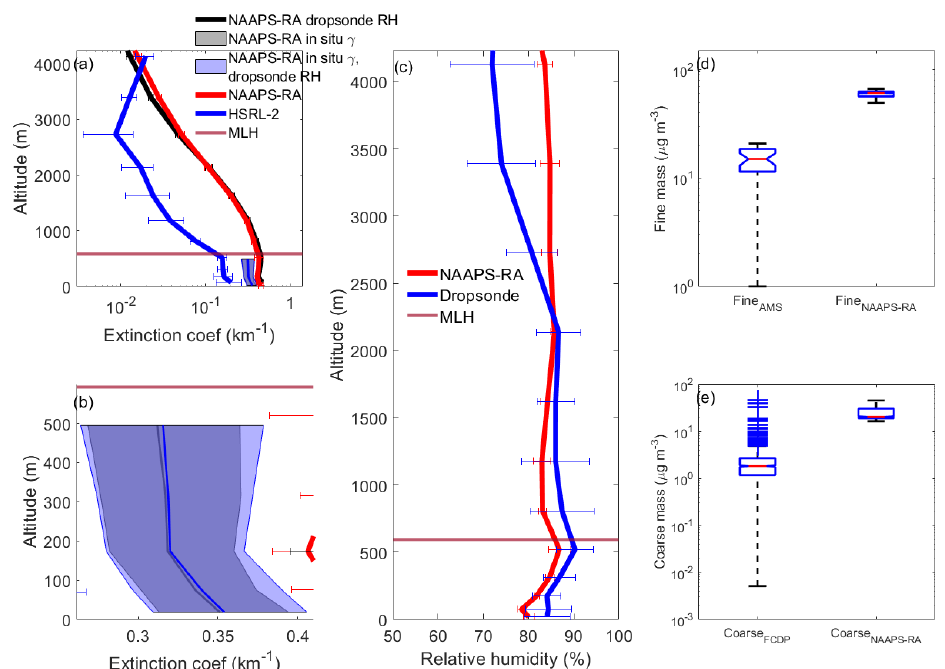
Figure 9. Same as Fig. 7 except for Case III (RF10) on 16 September 2019. The MLH is 593m.